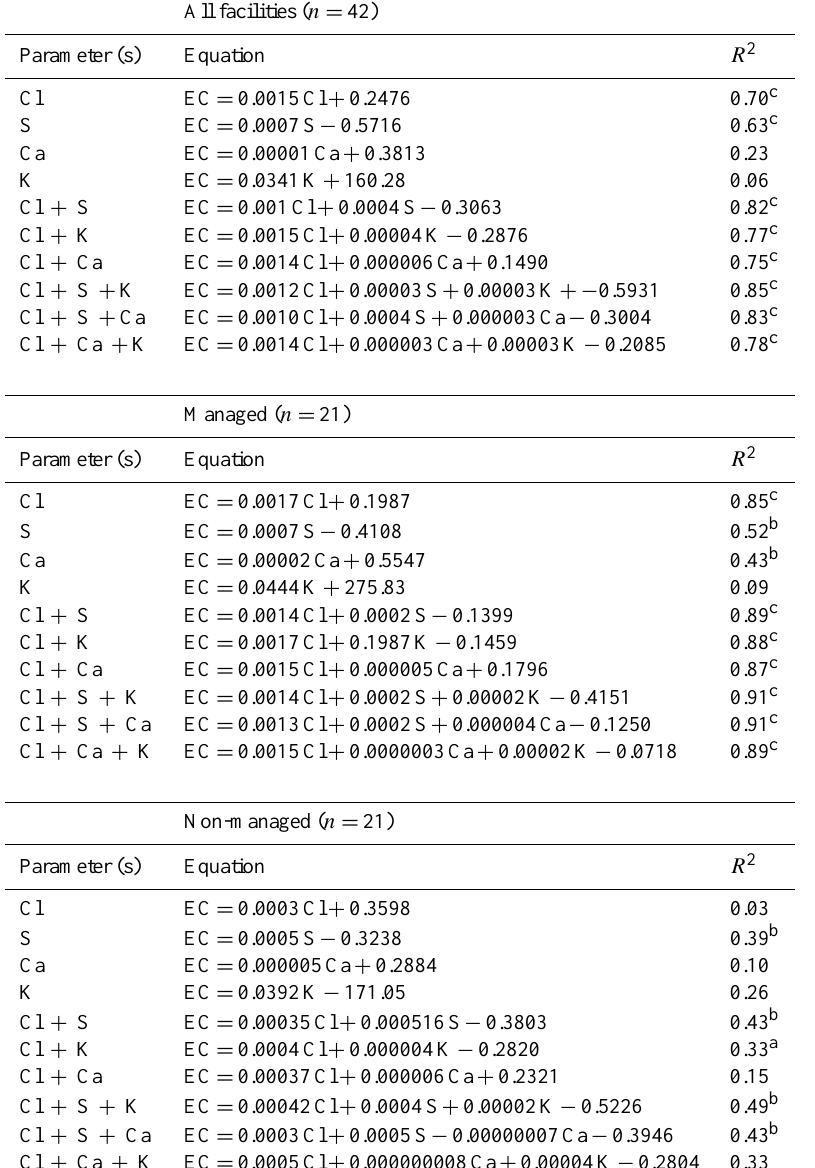
Table 4. Regression equation and coefficient of determination for the relationships between electrical conductivity (EC) and the selected PXRF-quantified elements within managed and non-managed facilities of the golf courses in Lubbock, Texas, USA ( n =